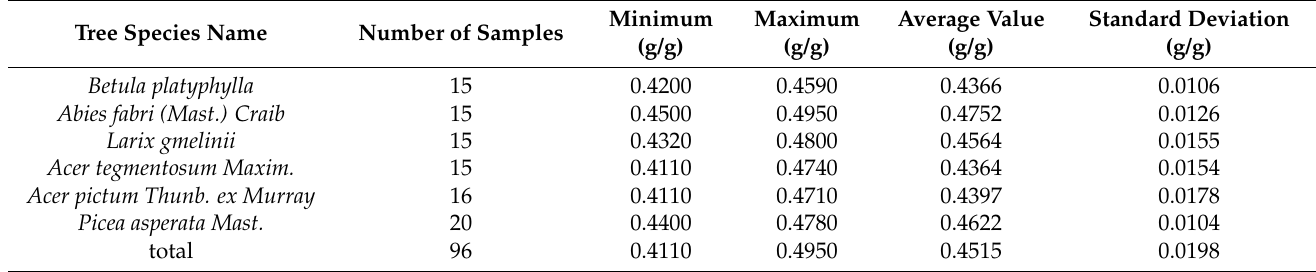
Table 1. Carbon content statistics of tree